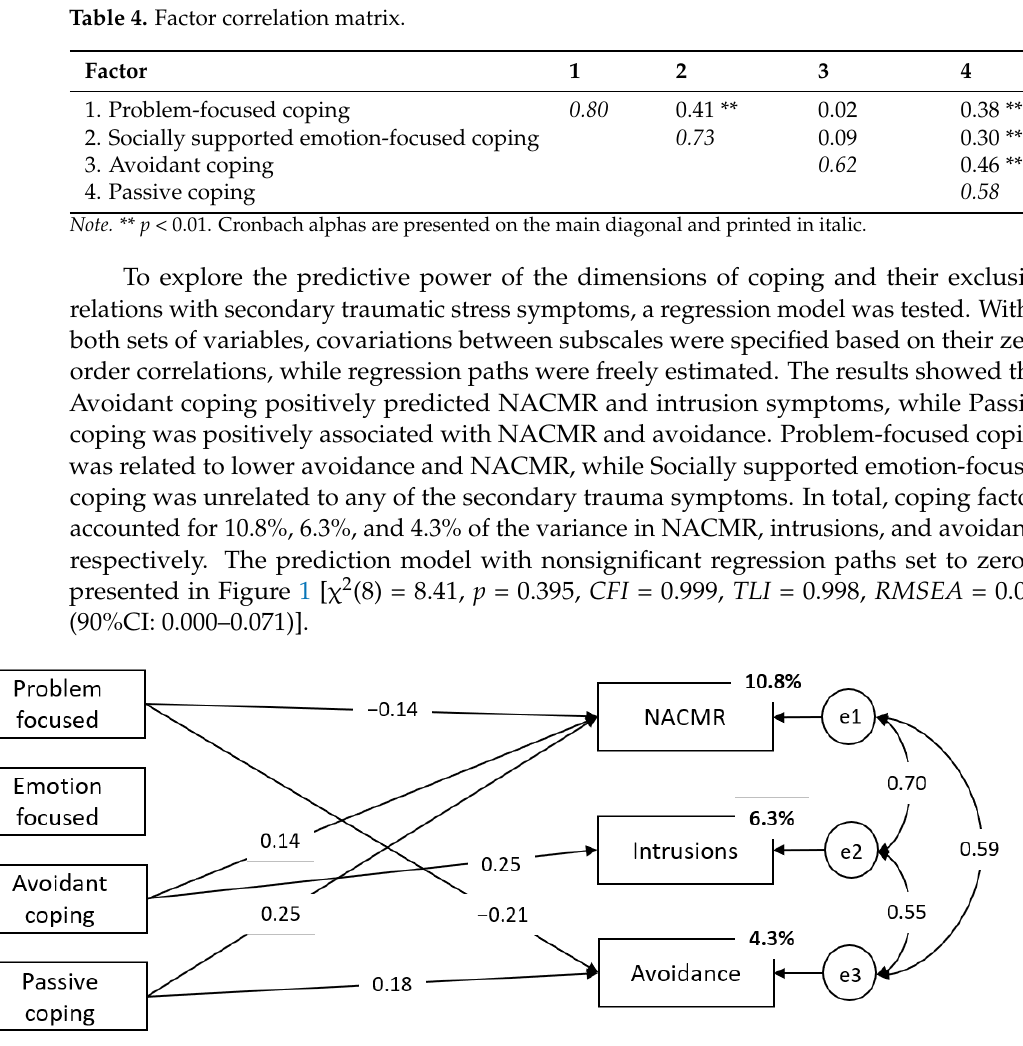
Table 4. Factor correlation matrix.